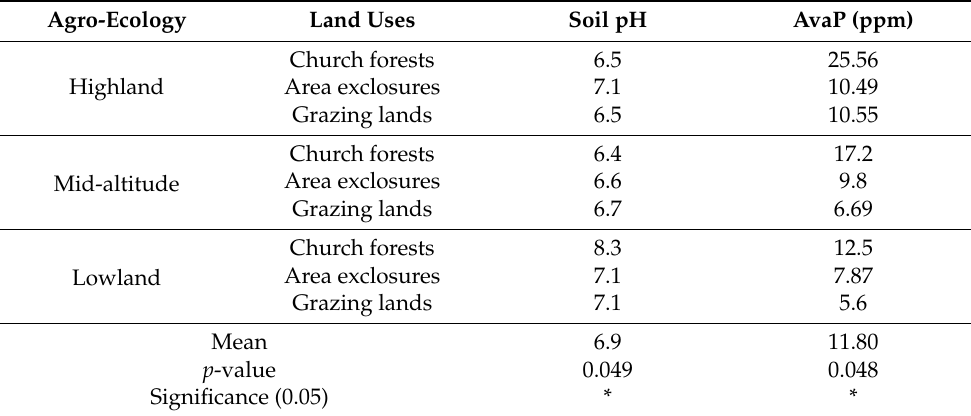
Table 8. Soil pH and available phosphorus in different soil depths and land